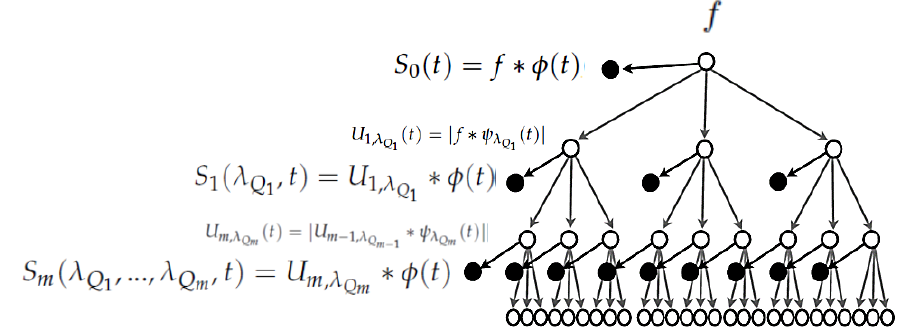
Figure 1. Wavelet Scattering decomposition